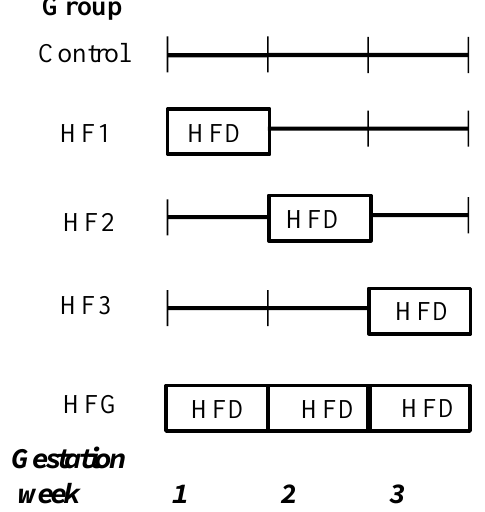
Figure 1. Experimental groups. The fetuses were maintained (through their mothers’ nutrition) on a high fat diet (HFD) for either the first week (HF1), second week (HF2), third week (HF3) or all 3 weeks (HFG) of fetal life.